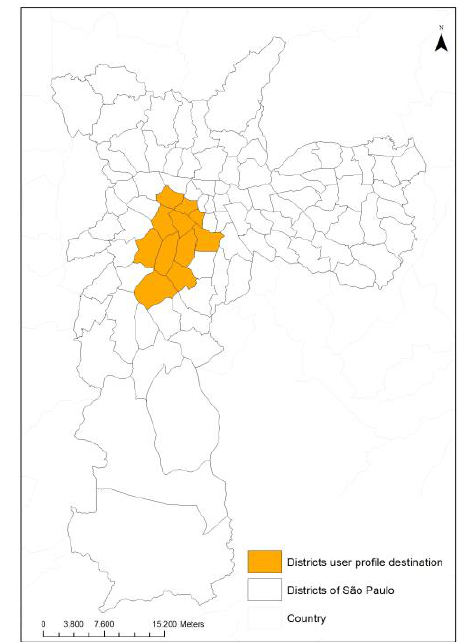
Figure 4. Preferential districts of origin according to user’s profile of carsharing (Source: Authors)